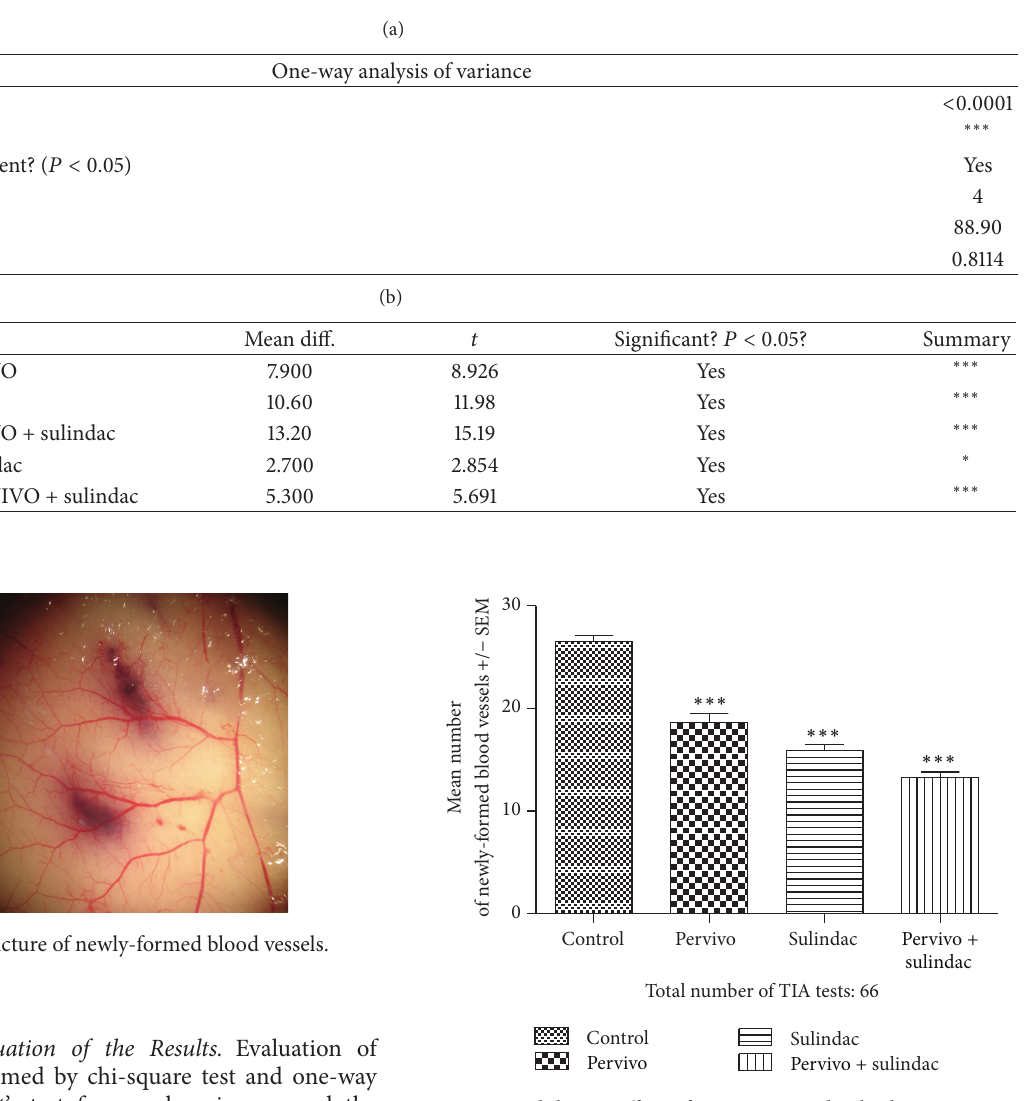
Figure 2: Inhibitory effect of PERVIVO and sulindac on neovas- cular reaction induced in mice skin after grafting L-1 sarcoma cells. ∗∗∗ 𝑃 < 0.001